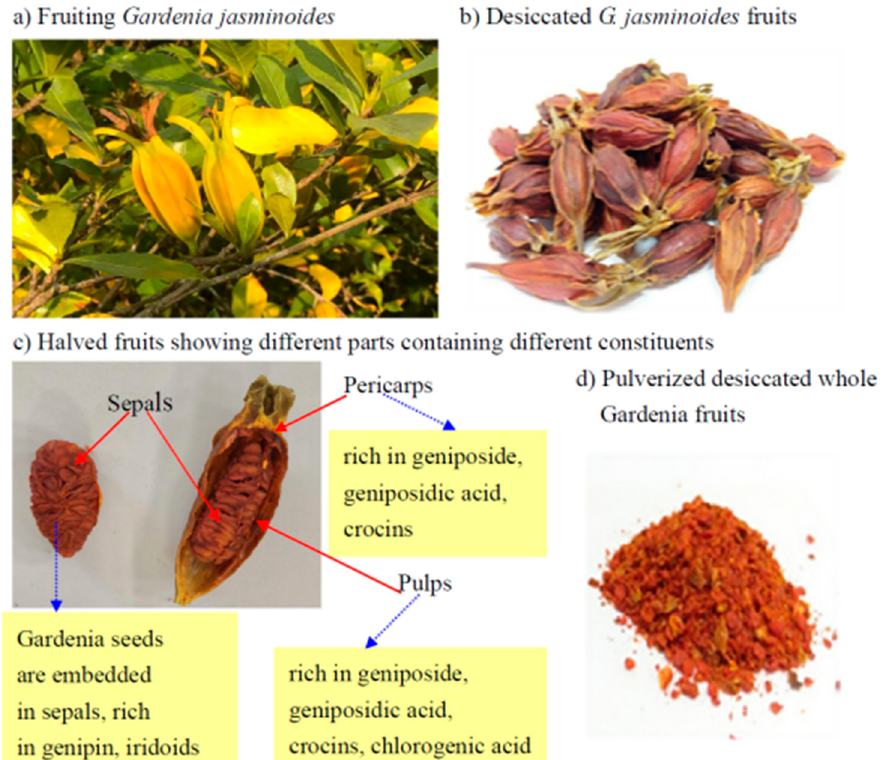
Figure 1. Gardenia jasminoides fruits and constituents. ( a ) fruiting G. jasminoides, ( b ) dried fruits, ( c ) different parts contain different constituents, ( d ) pulverized whole fruits for extraction and isolation of geniposide and crocins.